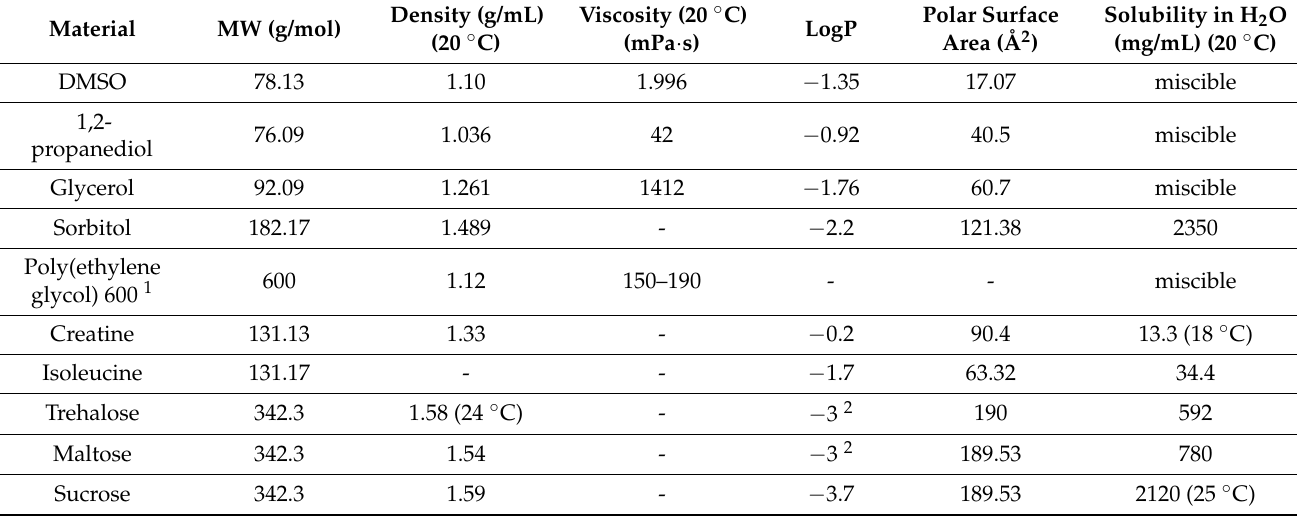
Table 7. Basic chemical properties of excipients used in DMSO-free cryopreservation formulations of T cells.